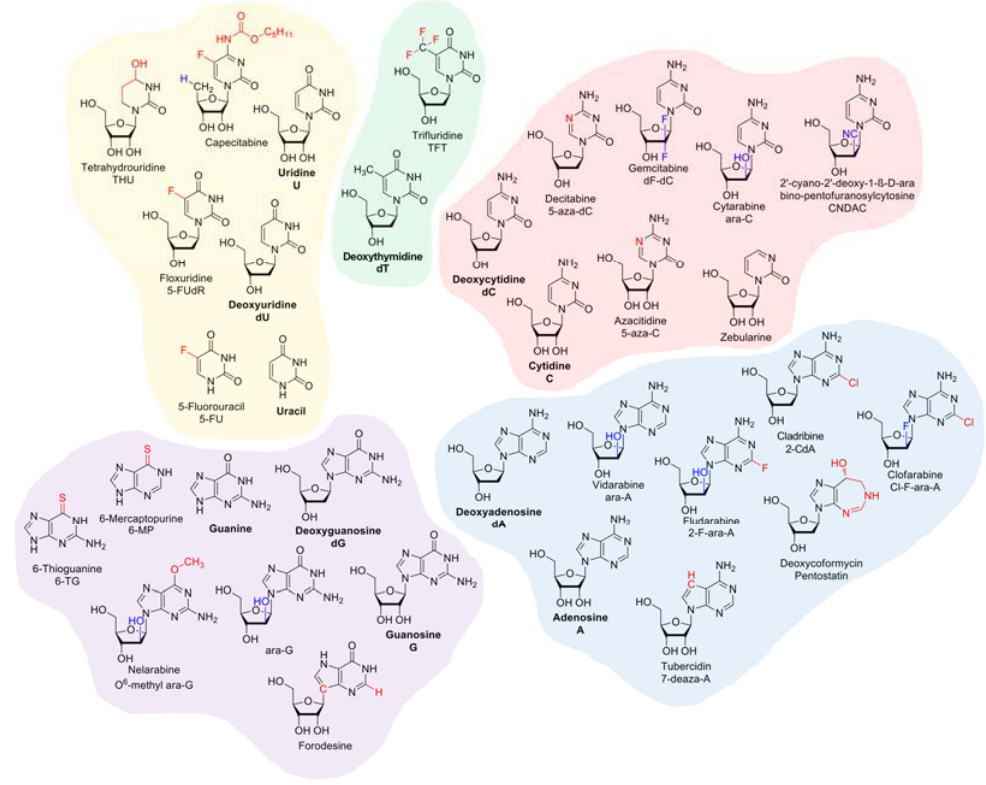
Figure 1. Structures of nucleobase and nucleoside analogues discussed in this review. Endogenous nucleobase/nucleosides are labelled in bold and synthetic analogues with sugar ‐ modifications (indicated in blue) or base ‐ modifications (indicated in red) are shown.